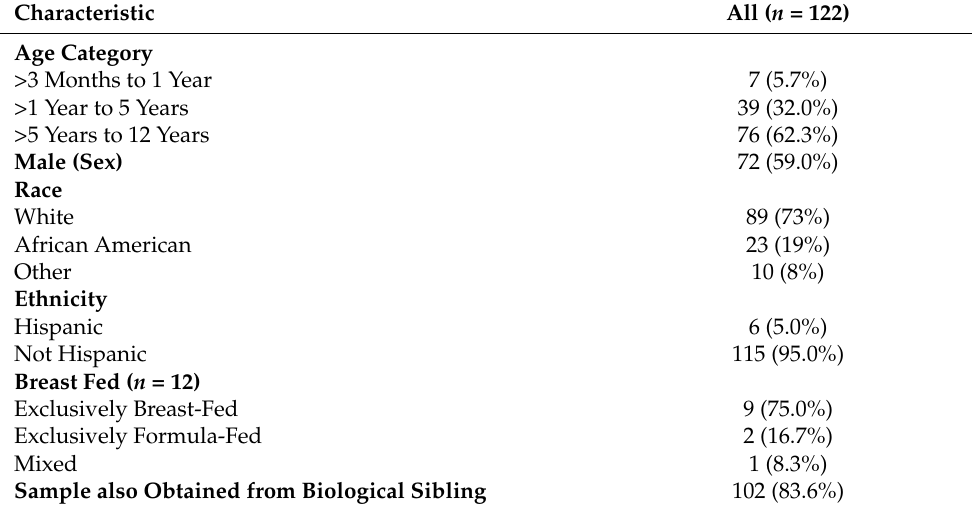
Table 1. Characteristics of the study